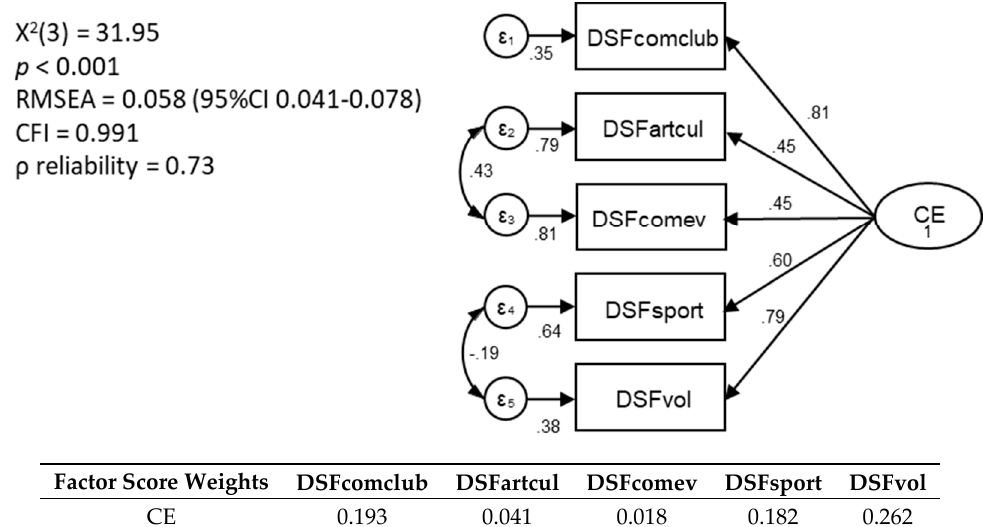
Figure A2. Final model for Civic Engagement constructs of community participation.